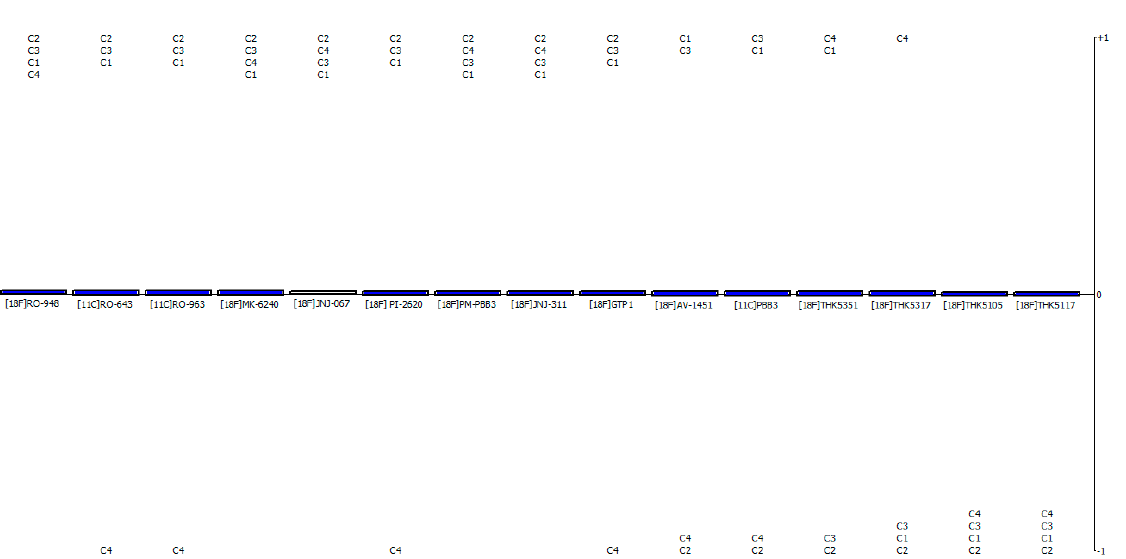
Tau PET radiotracers’ strengths and weaknesses, as well as their final ranking, are depicted in Figure 1. Every tau radiotracer that was considered for this analysis is ranked from the most preferred to the least preferred in this graph. The strengths of the alternatives are represented by criteria with values greater than 0, while weaknesses are indicated by values below 0. A diagram is used to show the overall process’s flow, with the various options listed from best to least on the horizontal axis. The criteria form a vertical bar to depict the alternatives available. Each segment of the bar illustrates how a different criterion impacts the net flow value of the alternatives. When a criterion is provided, its relative importance is shown as a weighted vertical bar whose height is proportional to the disparity between positive and negative preference flow. The indicators at the vertical bar’s extremes have the most extreme positive and negative values.